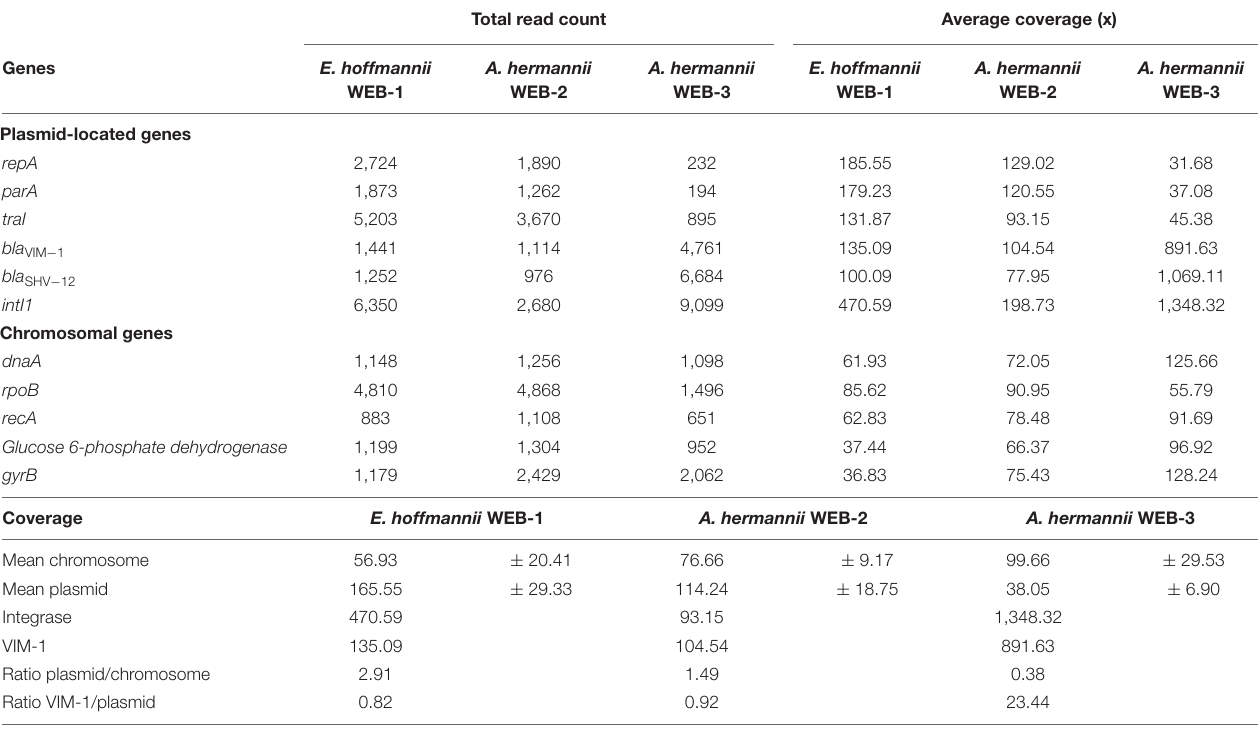
TABLE 3 | Total read count and average coverage for chromosomal and plasmid-located genes in E. hoffmannii WEB-1, A. hermannii WEB-2, and isogenic mutant A. hermannii WEB-3.